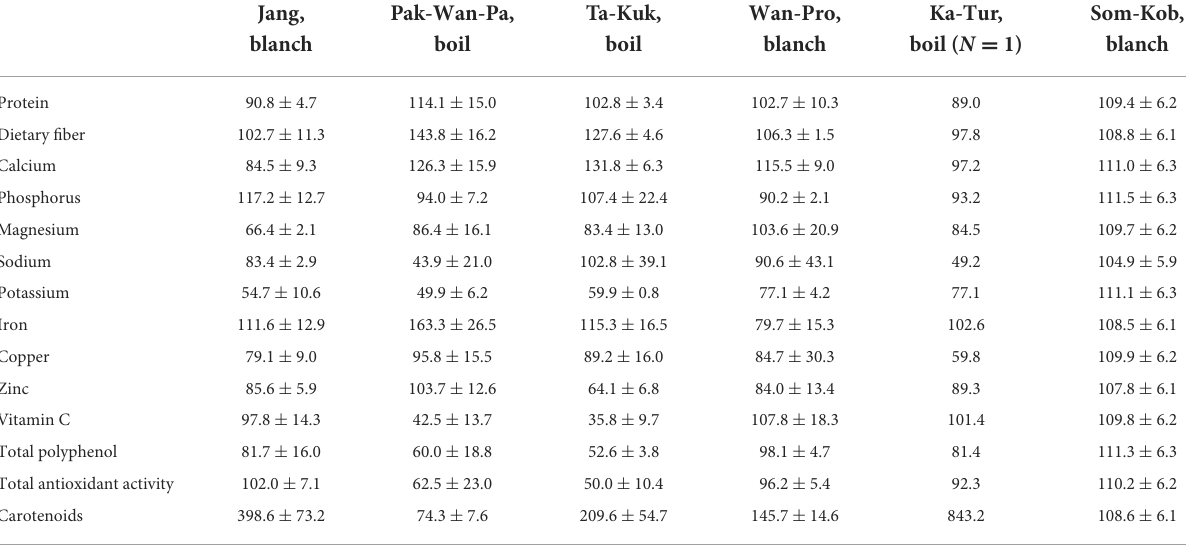
TABLE 5 Percentage true retention for the cooking methods of indigenous plants ( N = 3).